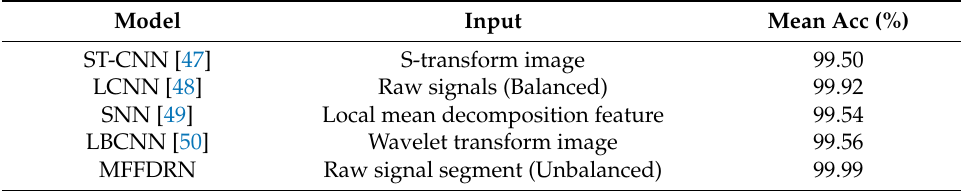
Table 7. Comparison of MFFDRN with some advanced methods in Case